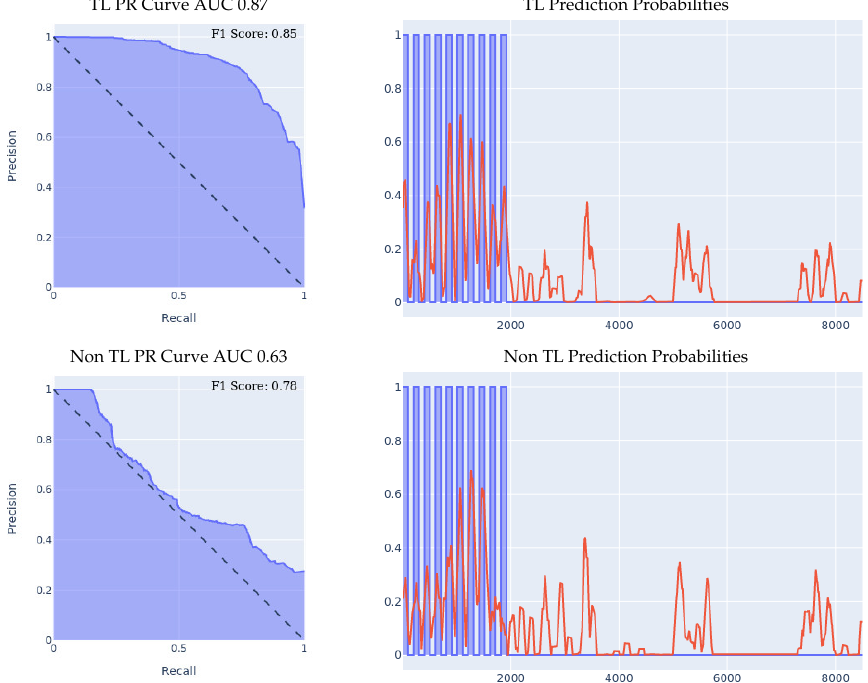
Figure 12. Leave-one-person-out data split experiment for ensemble models. For prediction proba- bilities, the x axis is the time, the y axis is the prediction threshold, the blue data is the real labels, and the red data is the prediction probabilities. For the F1 Scores, the averaged F1 score of all the 8 iterations of the cross-validation is shown in the top right corner of the PR